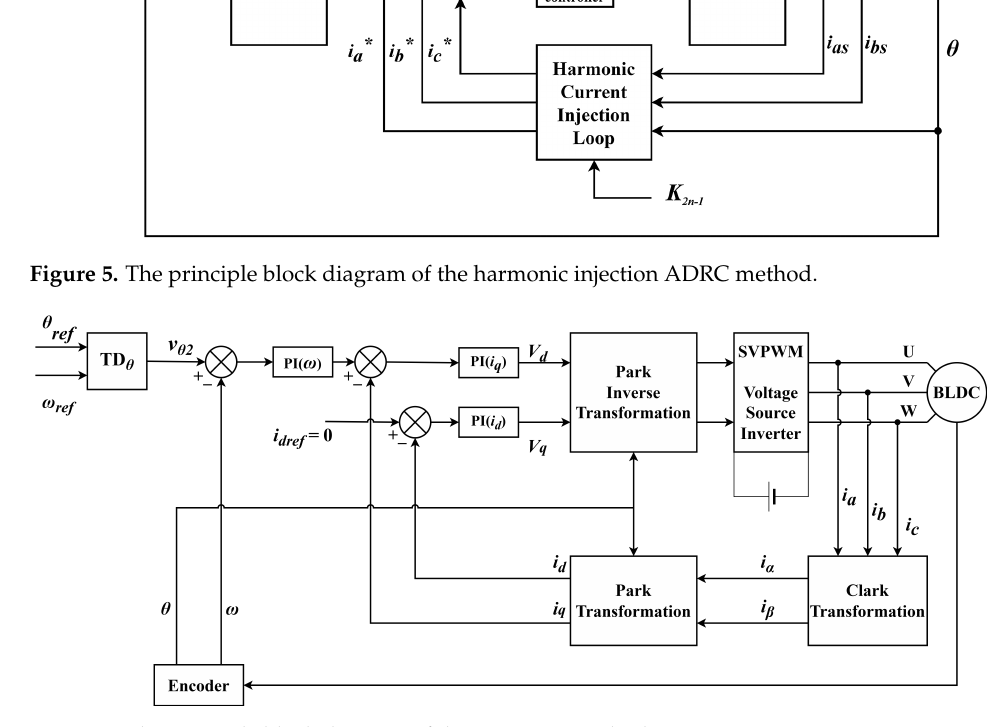
Figure 6. The principle block diagram of the PI + FOC